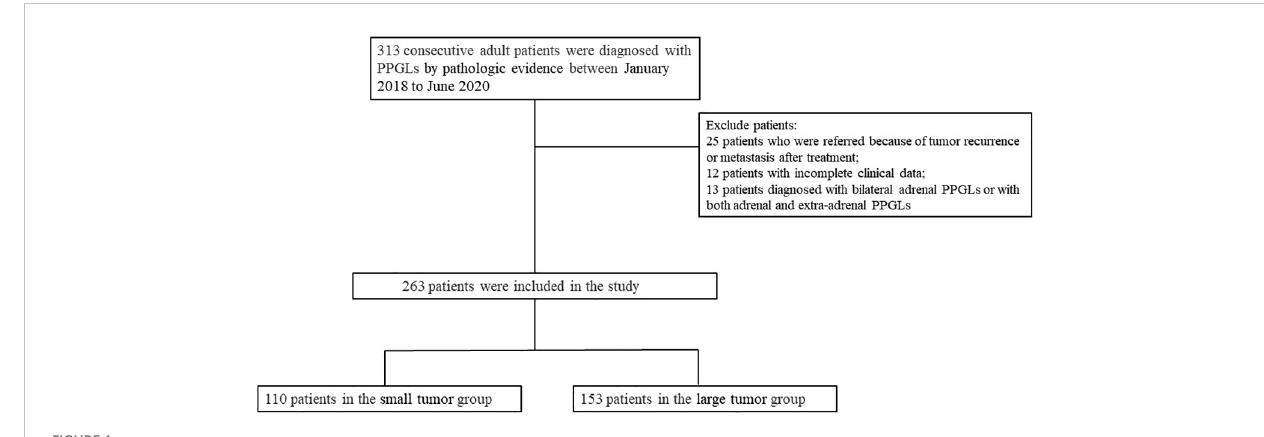
FIGURE 1 Flow chart showing the selection of patients. PPGLs: pheochromocytomas and